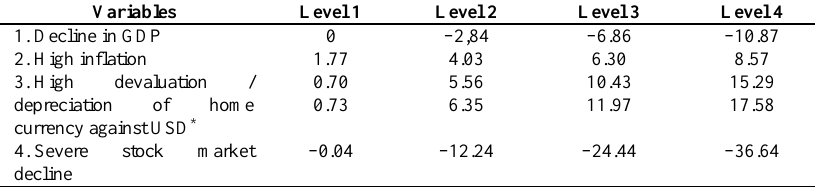
Table 3. Set 1 crisis thresholds (in %)